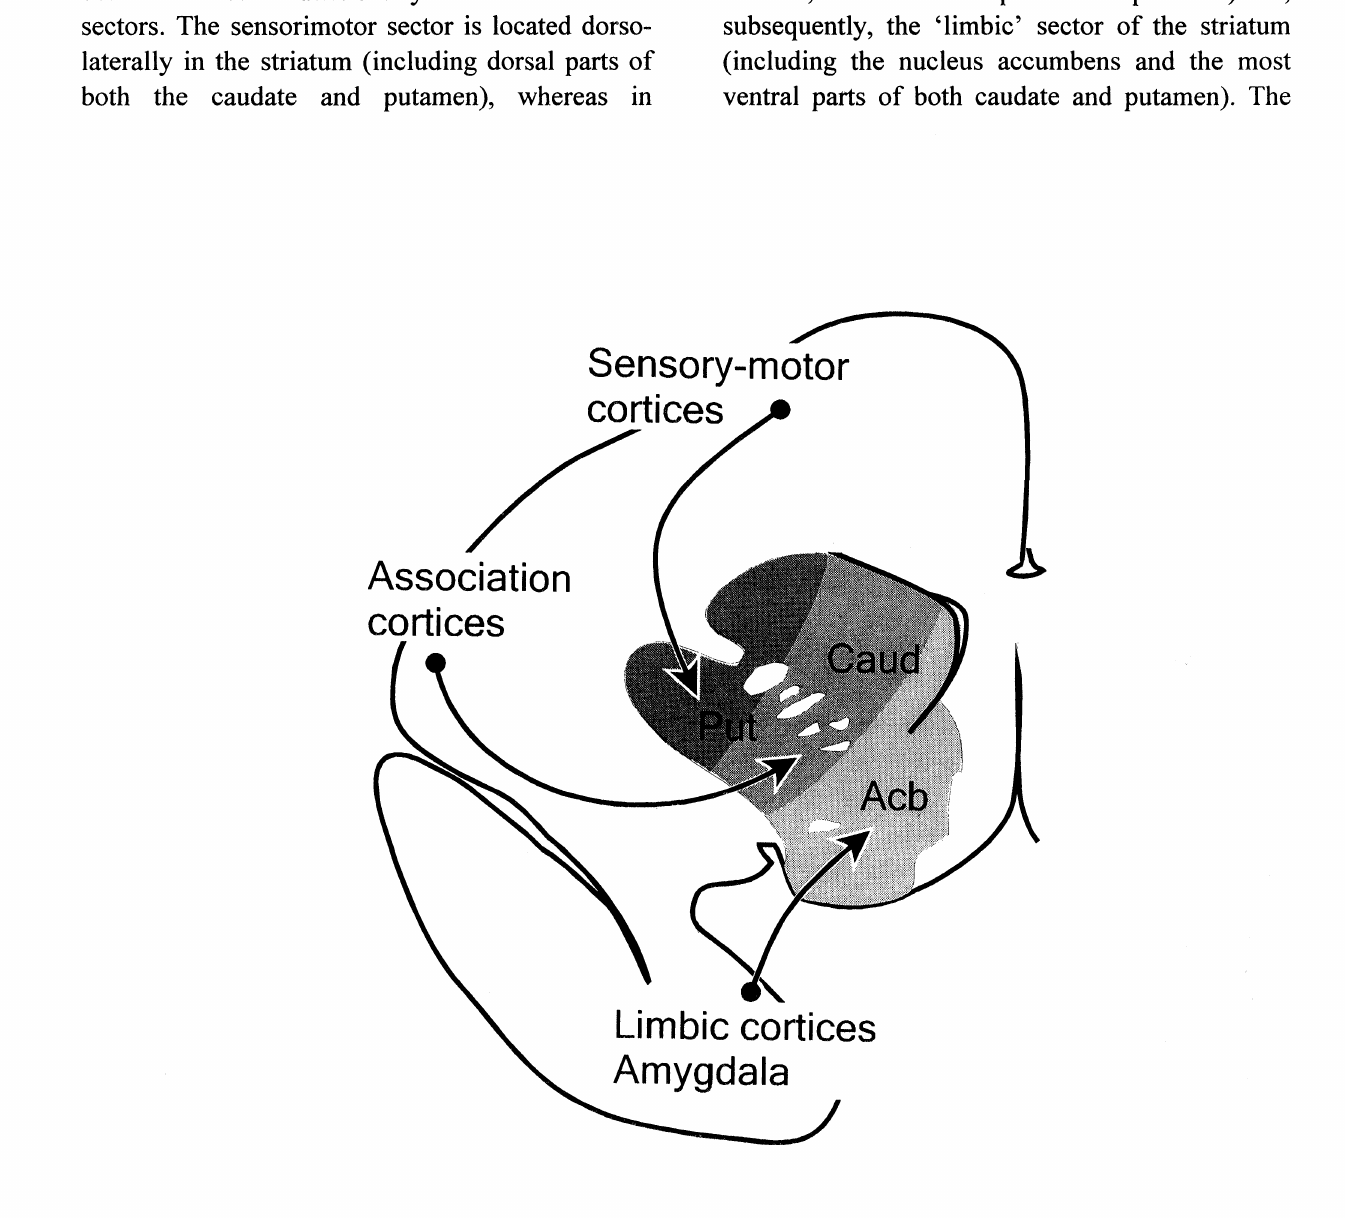
Fig. 3" Schematic representation of the topographic arrangement of the projections from functionally different cortical areas to the striatum, i.e., the caudate nucleus (Caud), putamen (Put), and the nucleus accumbens (Acb). The corticostriatal projections globally ’dictate’ the functional subdivision of the striatum in a dorsolateral ’sensorimotor’ part, an intermediate and medial ’cognitive’ part and a ventrolateral ’emotional/motivational’ part. Note that the functional zonation of the striatum which follows the corticostriatal organization does not comply with the macroscopic subdivision of the striatum in caudate nucleus, putamen and nucleus